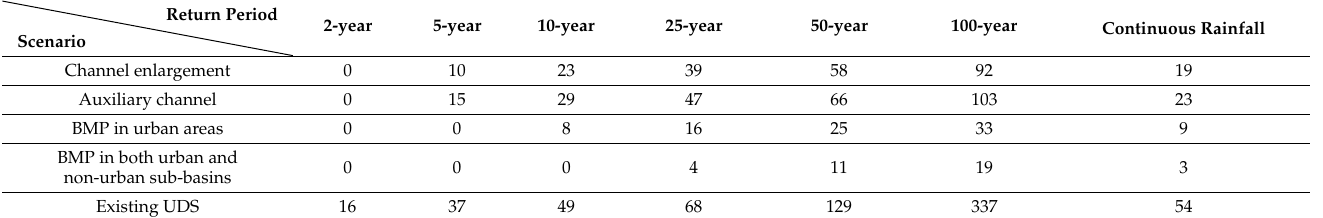
Table 3. Average surcharge (mm) from the UDS (i.e., degradation capacity) calculated for various scenarios.